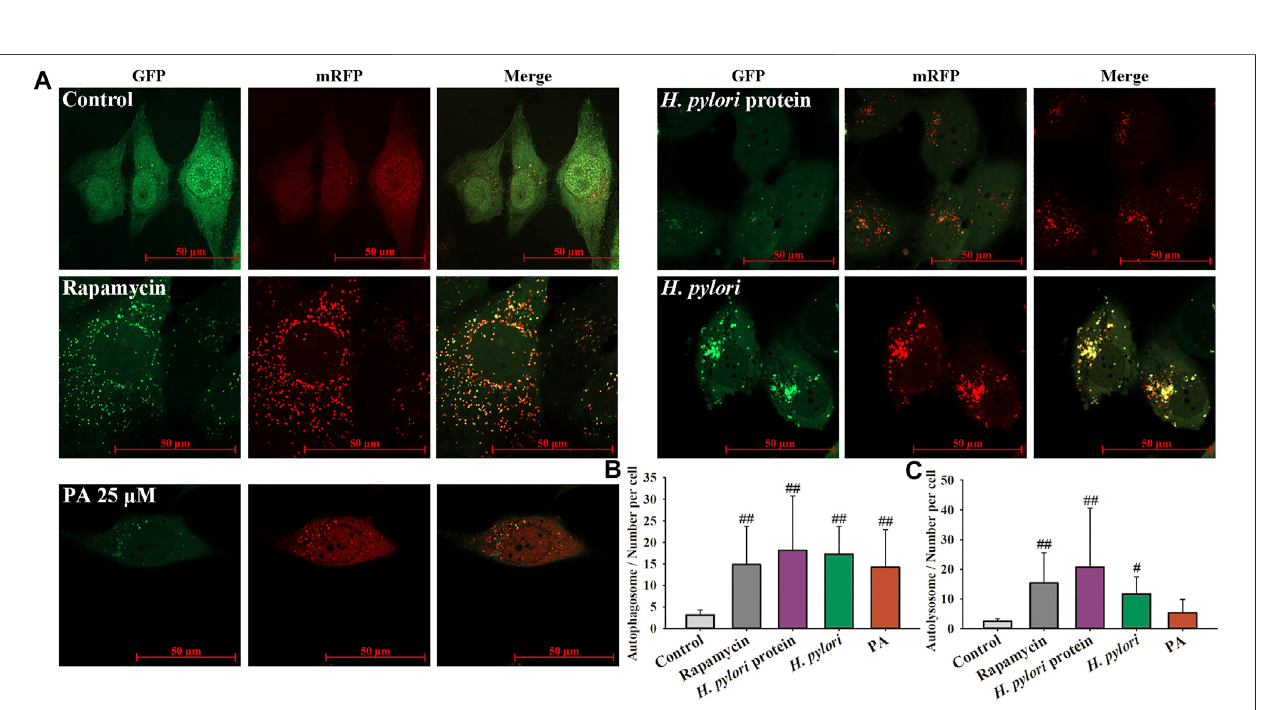
Frontiers in Pharmacology |